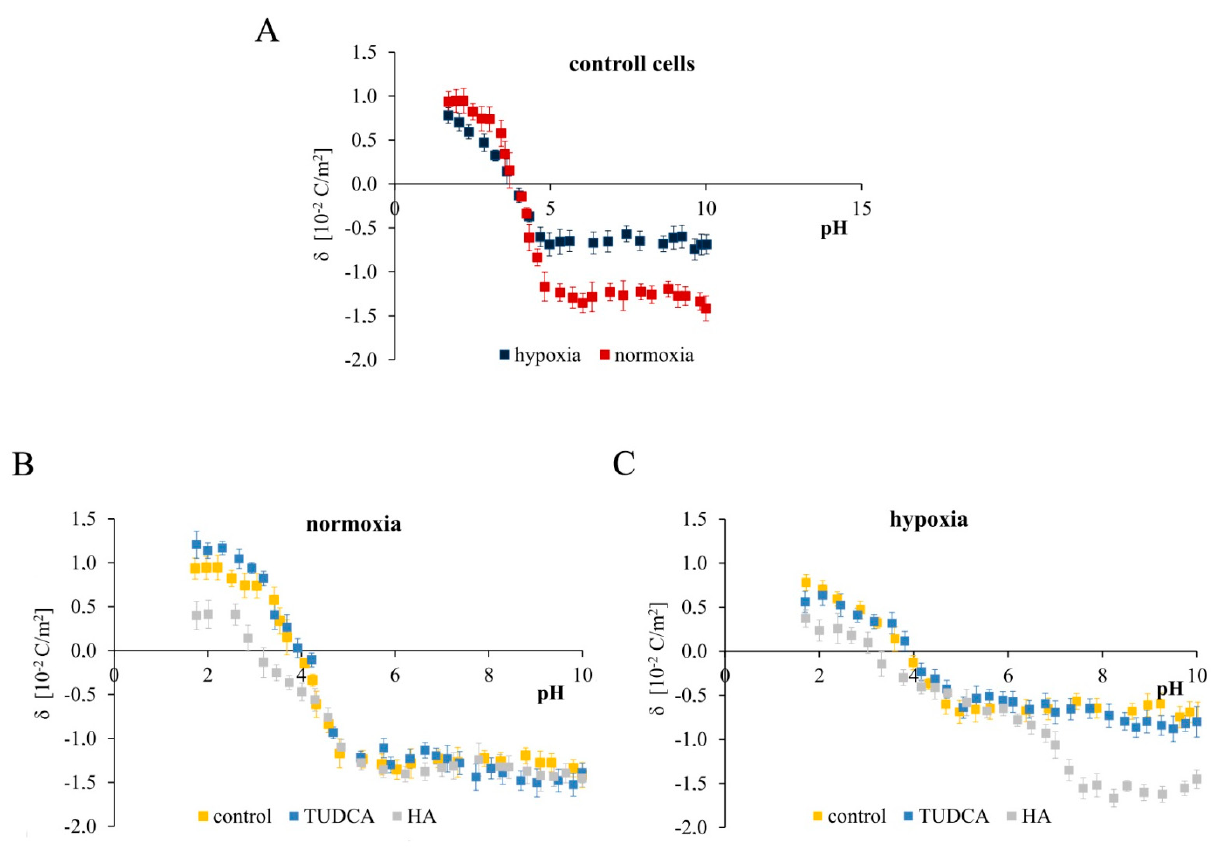
Figure 7. Typical pH-dependence of the surface charge density of NHAC-kn cell membranes. Results for untreated control cells cultured in normoxia vs. hypoxia ( A ), and control cells vs. cells treated with TUDCA and HA in normoxic ( B ) and hypoxic ( C ) conditions are shown.